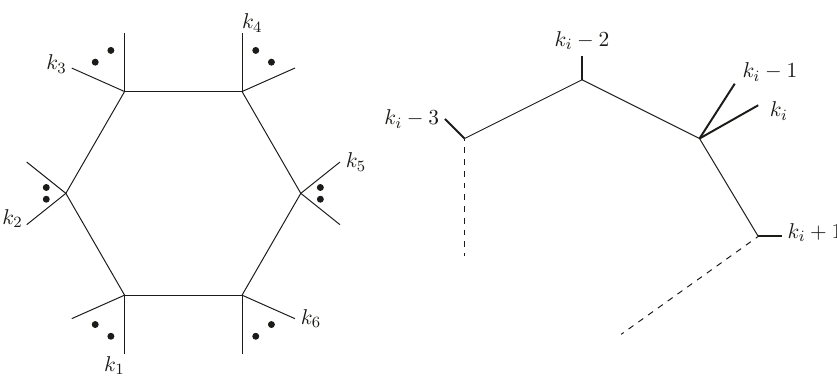
Figure 2 . Left: a choice of hexagon is determined by a choice of six external legs of I n . The coefficients are the ξ i s corresponding to the reduction of this hexagon to pentagons. Right: the basis of the reduction it corresponds to are the six ( n − 1 )-gons which are not ancestors of this